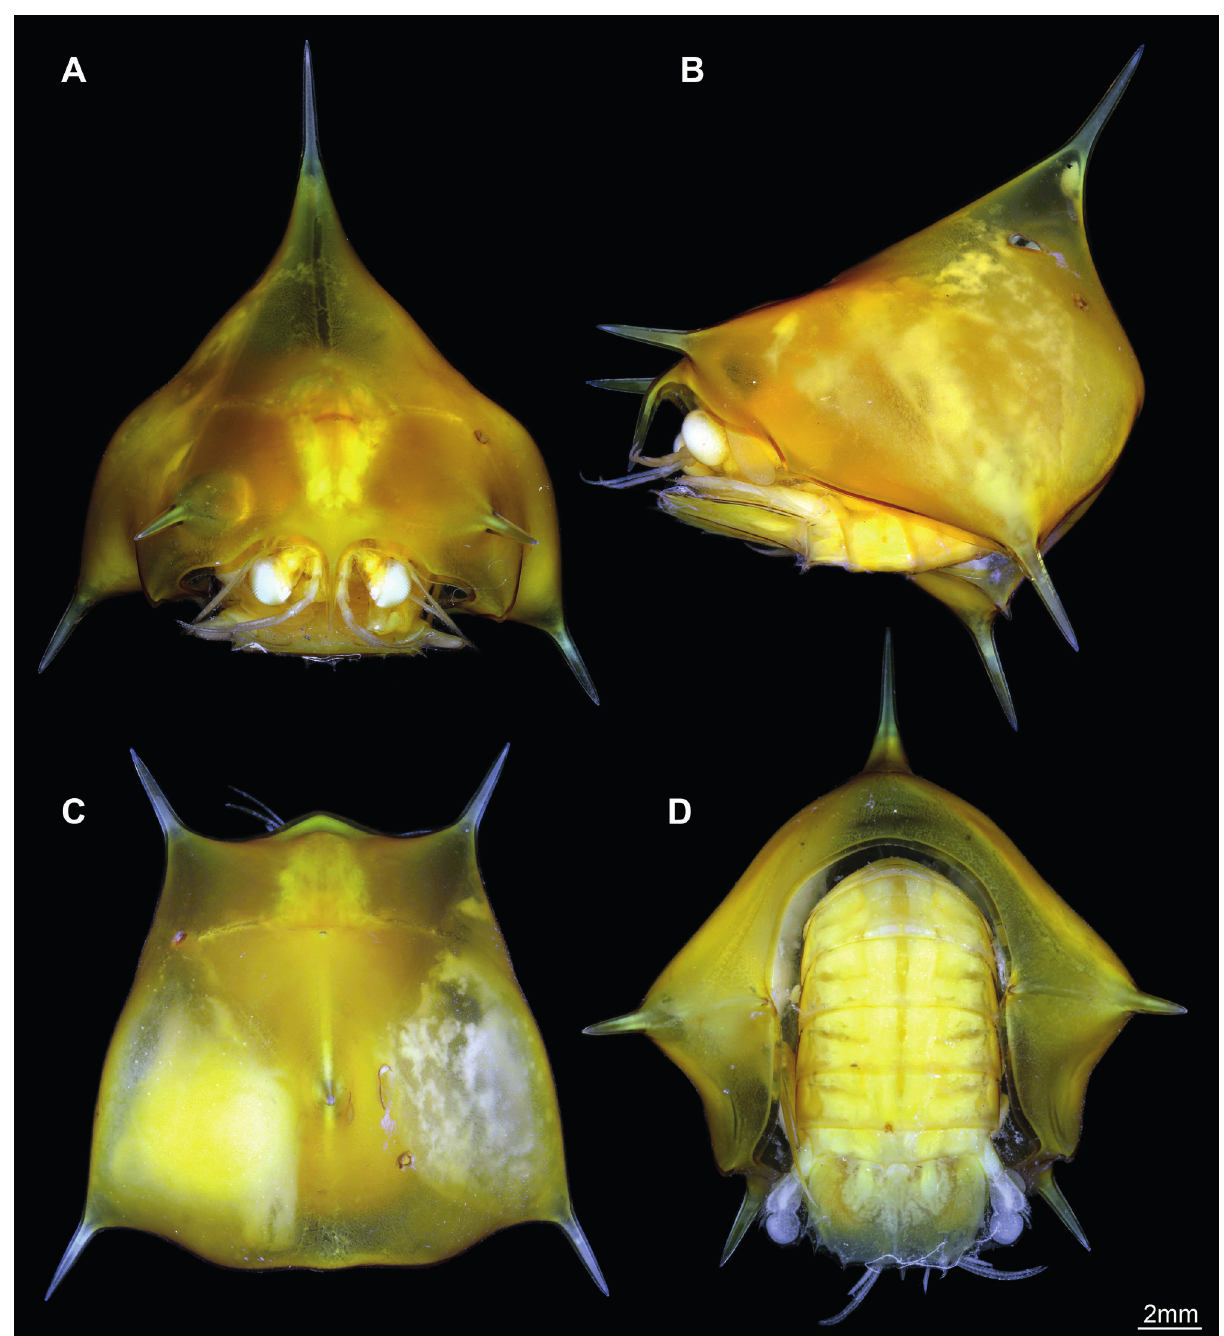
Figure 7. New morphotype 4, “gnome hat”; ZMUC-CRU-8661. A. Anterior view. B. Lateral view. C. Dorsal view. D. Posterior